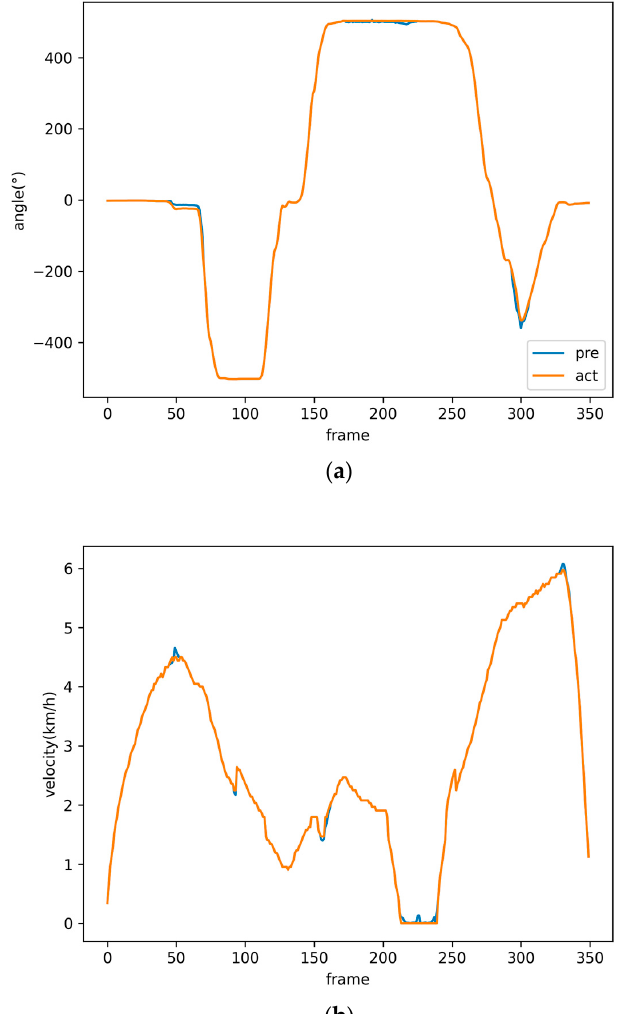
Figure 19. Predicted values compared to the skilled driver driving data: ( a ) Steering wheel turning angle curve. ( b ) Vehicle speed curve.